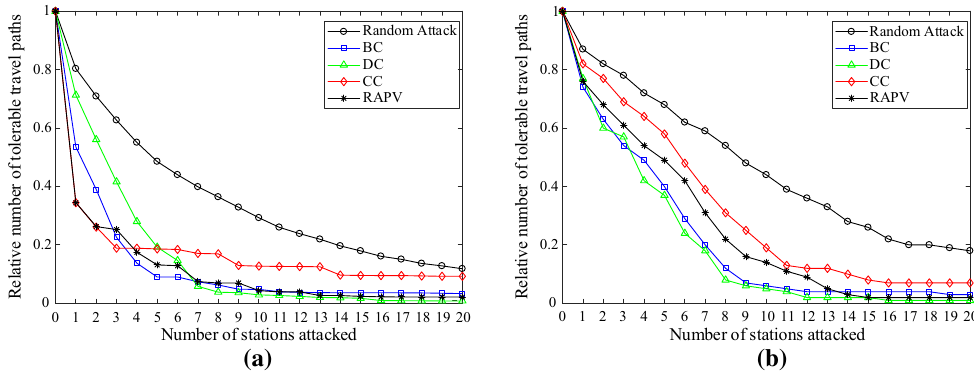
Fig. 2 Simulation output showing relative number of tolerable travel paths R path under five attack modes a during peak hours and b during non- peak hours